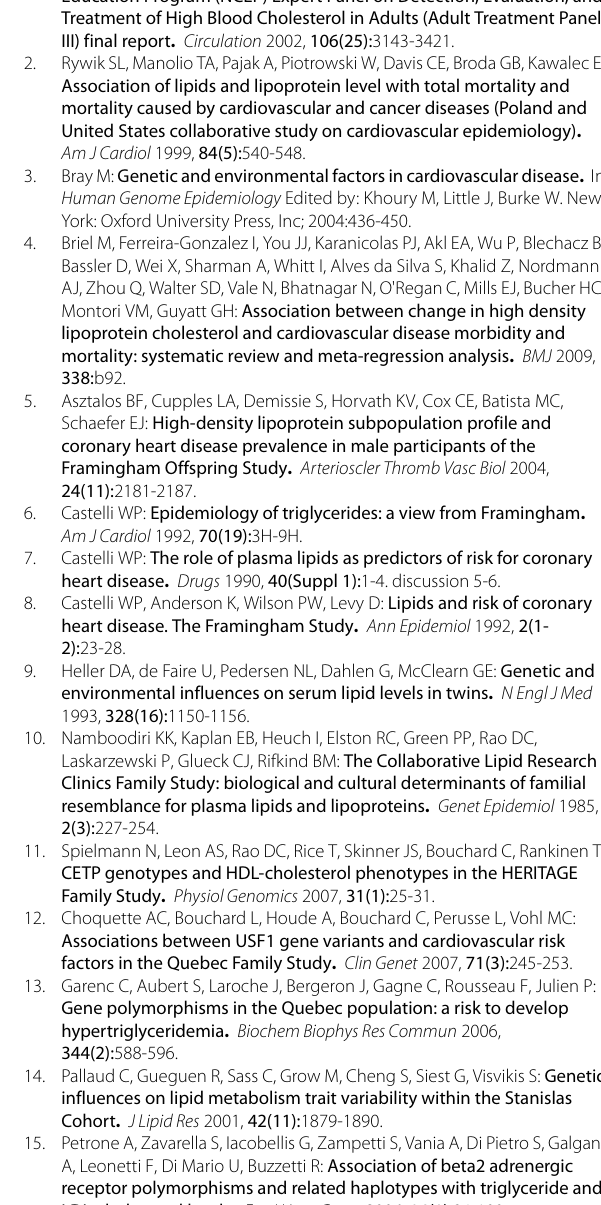
Additional file 1 Table S1. Allele frequencies by race/ethnicity - NHANES III (1991-1994). The allele frequencies by race/ethnicity are shown. Table S2. P-Values from the Univariate analysis for covariates - NHANES III (1991- 1994). The p-values from the univariate analysis of covariates are shown. Table S3a-d. Univariate analysis for HDL-C, LDL-C, TC, and TG, and candidate genetic variants by race/ethnicity - NHANES III (1991-1994). The univariate analysis for lipids and candidate genetic variants by race/ethnicity is shown. Table S4a-d. Association between HDL-C, LDL-C, TC, and TG, and selected genetic variants adjusting for covariates by race/ethnicity - NHANES III (1991-1994). The association, by race/ethnicity, between lipdis and selected genetic variants adjusting for covariates are shown. Table S5a-d. Crude hap- lotype analysis for HDL-C, LDL-C, TC, and TG, by race/ethnicity - NHANES III (1991-1994). The crude haplotype analysis for lipids by race/ethnicity is shown. Table S6a-d. Adjusted haplotype analysis for HDL-C, LDL-C, TC, and TG, by race/ethnicity - NHANES III (1991-1994). The adjusted haplotype analysis for lipids by race/ethnicity is shown. Table S7. Power calculation by race/ethnicity - NHANES III (1991-1994). Power calculation by race/ethnicity is